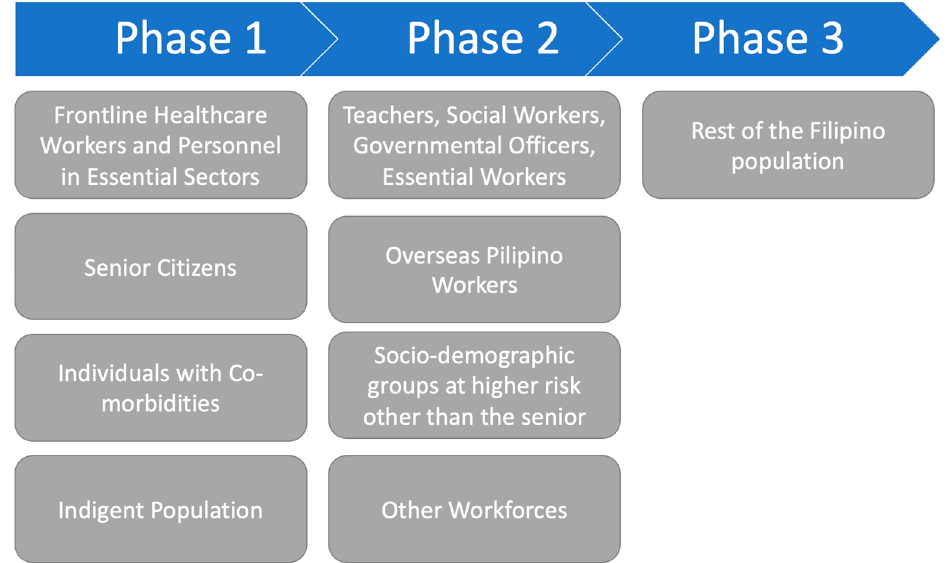
Figure 1. Vaccine Prioritization Framework [13].